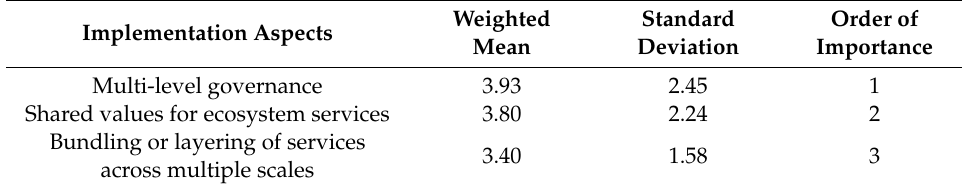
Table 6. The level of importance of concerned implementation aspect (Q4).